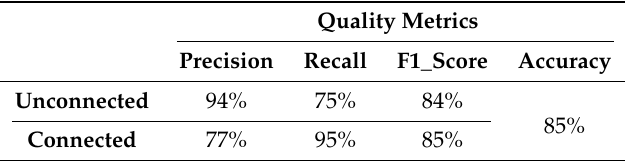
Table 5. Quality metrics for binary classification.